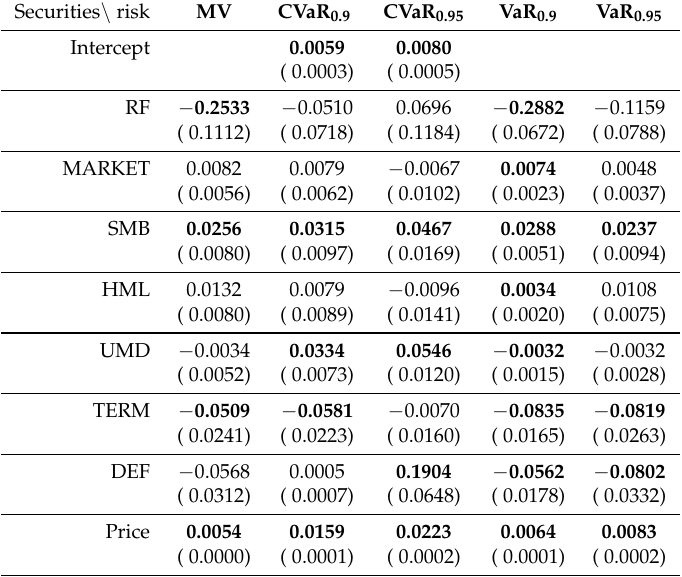
Table 6. Hedging of Consumption Growth. The table reports the estimates and their corresponding bootstrap errors (based on 400 bootstrap replications) for different risk measures (mean-variance MV, conditional value-at-risk CVaR, and value-at-risk VaR). The bold font represents statistical significance (at the 5% nominal level) of individual coefficients except for the last row where the bold font signifies a statistically different price from E ( y )